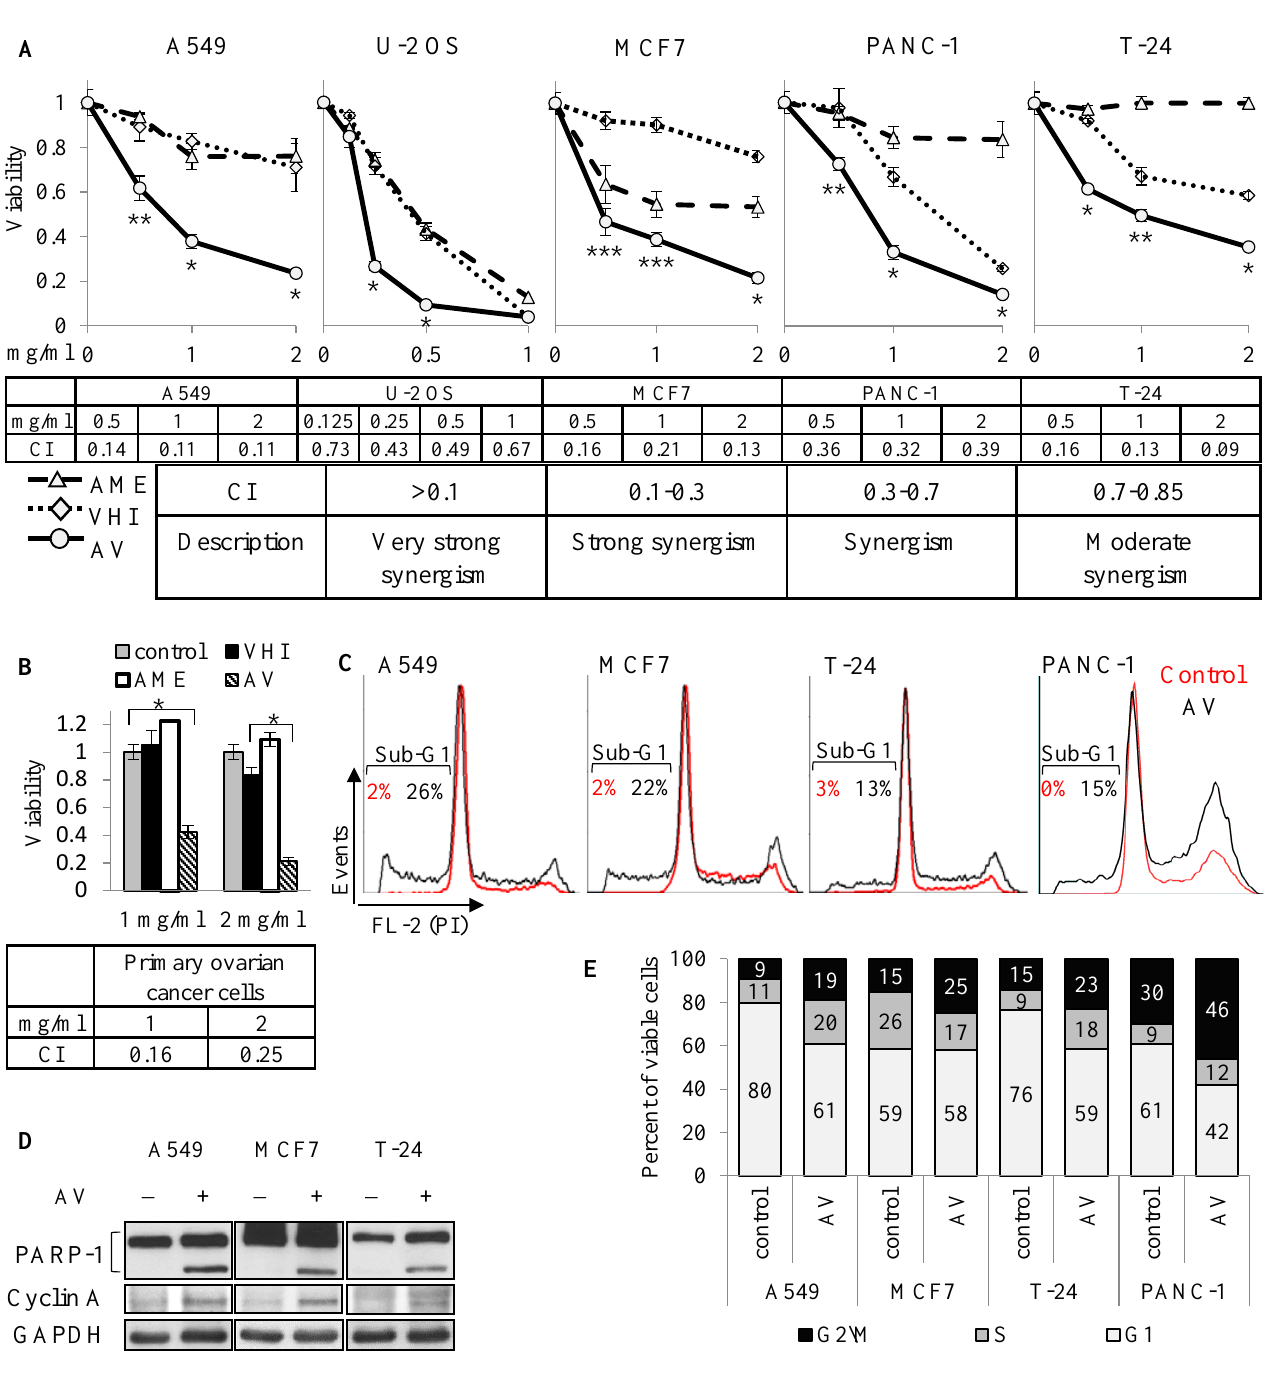
Figure 2. Synergic AME and VHI toxicity towards cancer cells. ( A ) Viability of cancer cell lines upon 72 h treatment by rising concentrations of AME, VHI or 1:1 mix (AV). Combinational Index (CI, table below the graphs), calculated using CompuSyn program; ( B ) Same as in ( A ) for primary ovarian cancer cells; ( C ) Cell cycle analysis of cells treated with 2 mg/mL of AV for 72 h, showing sub-G1 (apoptotic) population (the graphs are normalized to similar G1 peak in control and treatment samples). ( D ) Western blot of cells treated with 2 mg/mL of AV for 72 h showing apoptotic PARP- 1 cleavage and cyclin A accumulation; ( E ) Same as ( C ), showing percent of cells in G1, S and G2/M phases, calculated from non-apoptotic population.*— p -value < 0.001, **— p -value < 0.01, ***— p -value < 0.05, as compared between AV point and the closest relevant value of other compared groups (control or single botanicals). CI – combinational index; G1, S, G2/M – phases of cell cycle; FL-2 (PI) – fluorescence channel – 2 (propidium